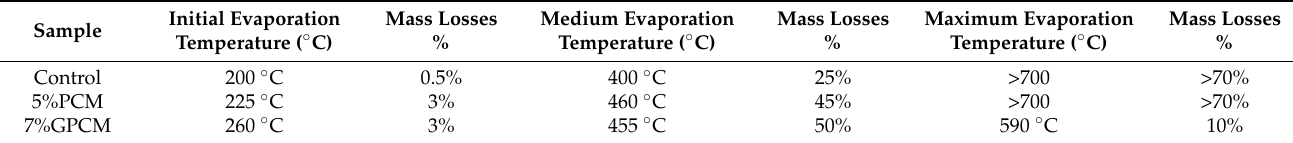
Table 4 . Initial, medium, and maximum evaporation temperatures obtained from TGA .